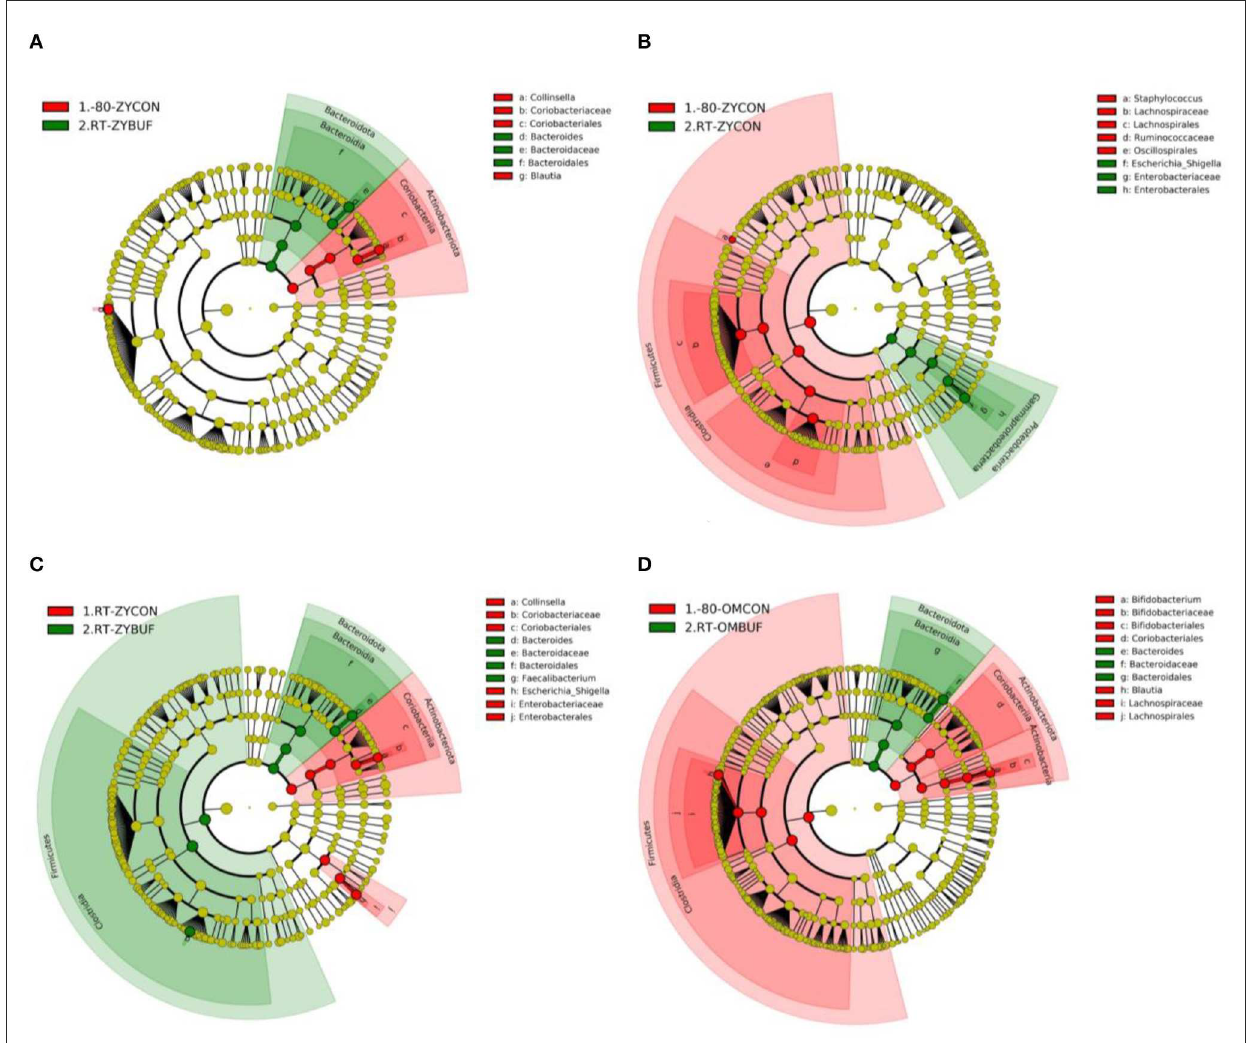
FIGURE4 LEfSe analysis showing the significant distinguishing taxa between the different storage methods based on an LDA score > 4.0. Results are shown in cladograms, showing the effect of storage at RT, with or without stabilization buffer (RT-ZYBUF, RT-ZYCON, RT-OMBUF) in green, compared to the control samples ( − 80-ZYCON, − 80-OMCON, RT-ZYCON) in red. (A–D) The Cladograms show the taxonomic levels represented by rings, with the phylum level in the outermost ring, and the genus level in the innermost ring. Each green or red circle represents significantly different taxa associated with one of the compared